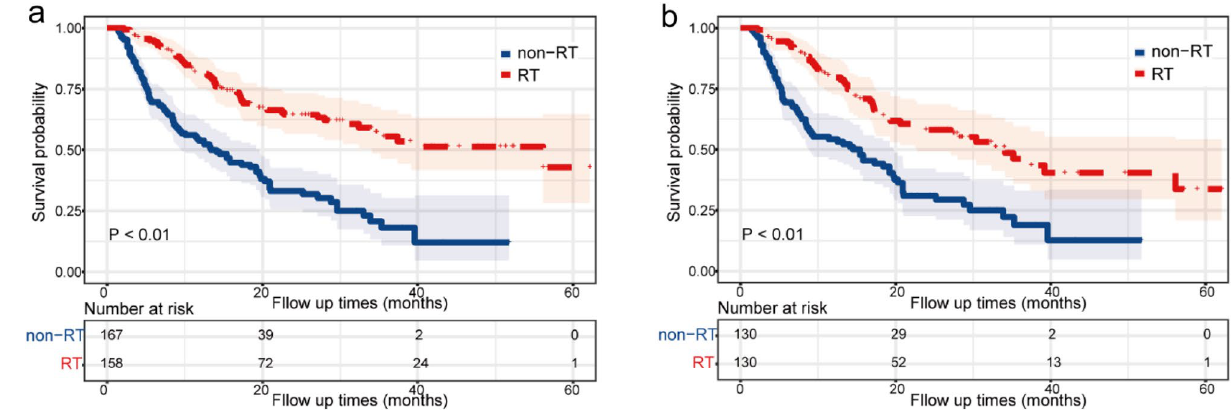
Figure 6. Kaplan–Meier overall survival (OS) estimates and 95% confidence intervals for patients in the RT and non-RT groups at three tertiary hospitals in China: ( a ) pre-PSM and ( b ) post-PSM. PSM propensity score matching, RT